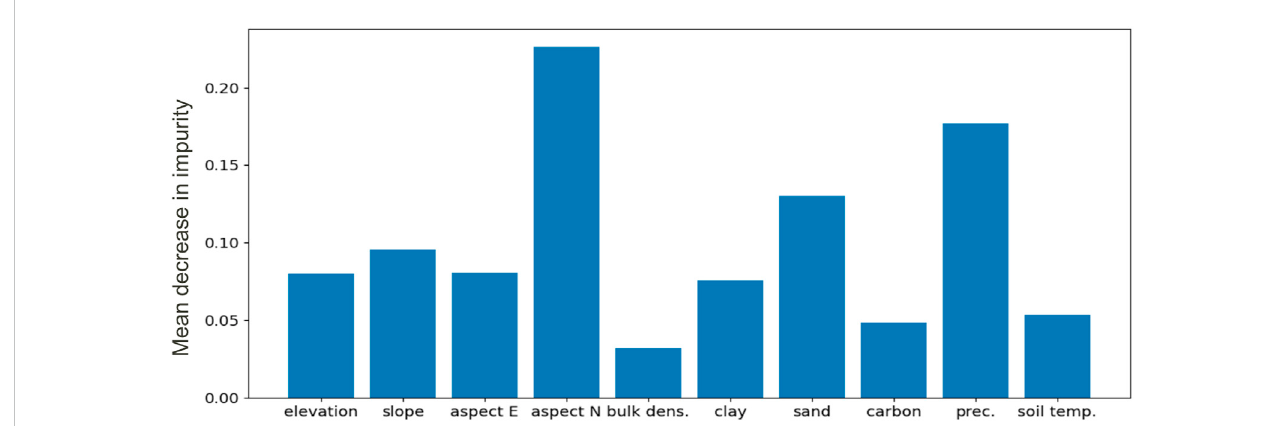
FIGURE 6 Relative feature importance within the training dataset for the deterministic random forest model.